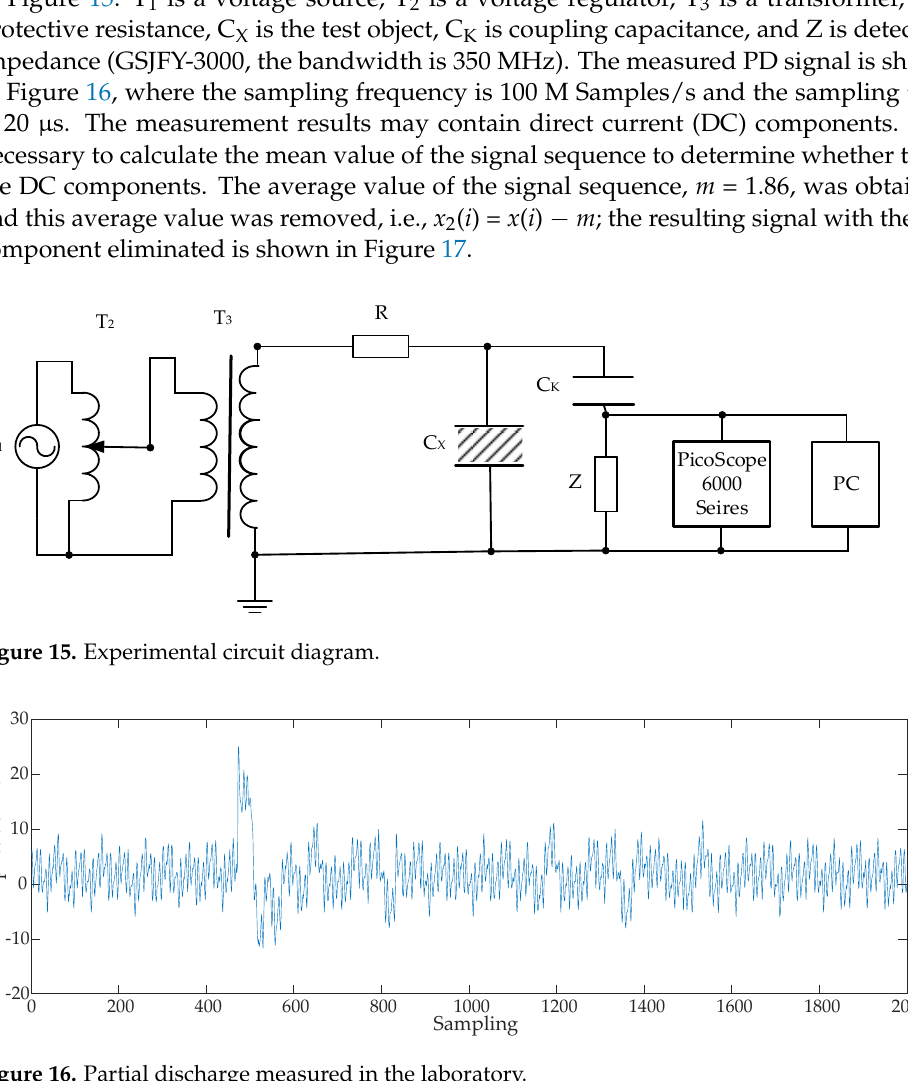
Figure 16. Partial discharge measured in the laboratory.